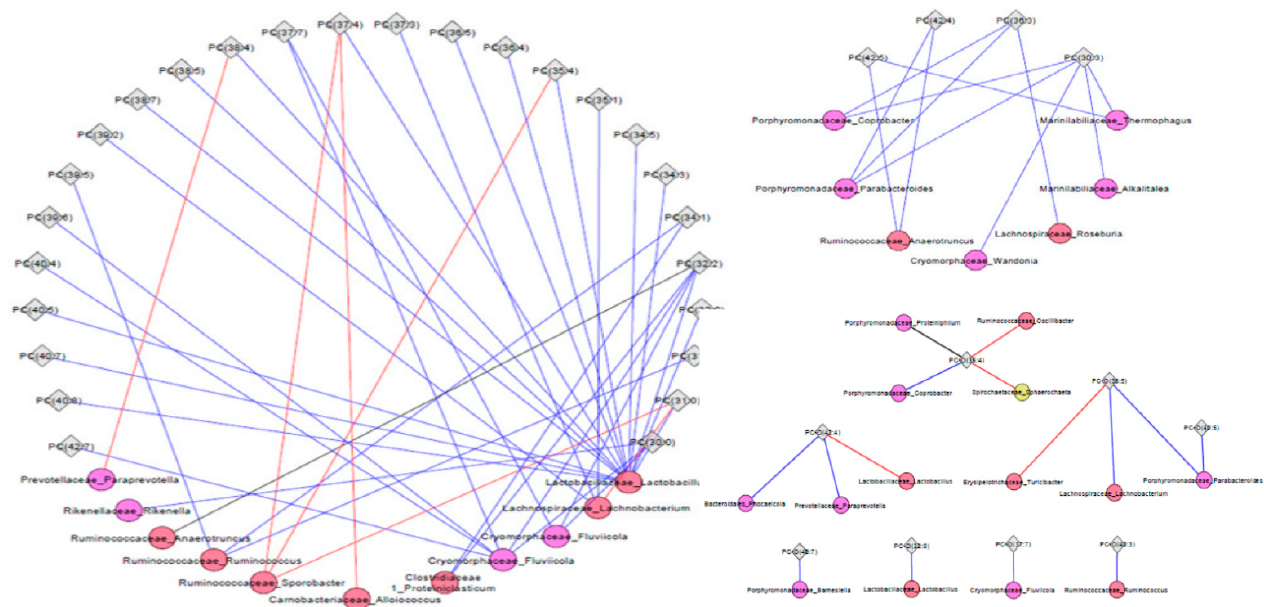
Figure 5. Bacteria-metabolite network visualization in the hippocampus of pigs fed six servings of WBM-supplemented diet. Bacterial genus in the fecal microbiome and the most abundant metabolite lipid species phosphatidylcholine and alkyl-acyl-glycerol phosphocholines compared between pigs fed six servings of WBM versus and control diets. Bacterial genus is represented by circles and hippocampus metabolites by diamonds. Change from negative to positive correlation are shown in blue, while change from positive to negative is shown in red. Only significant correlations are shown ( p -value < 0.05).